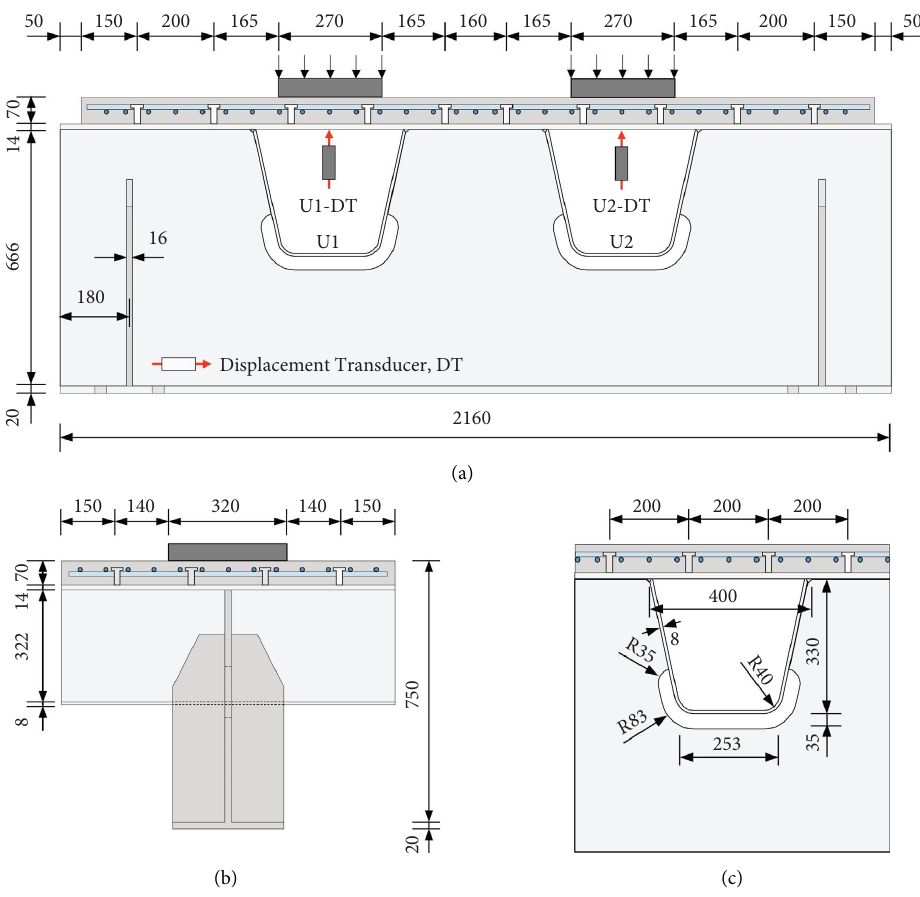
Figure 3: Geometry of transverse specimen (unit: mm): (a) cross section view; (b) side view; (c) details of cross section of